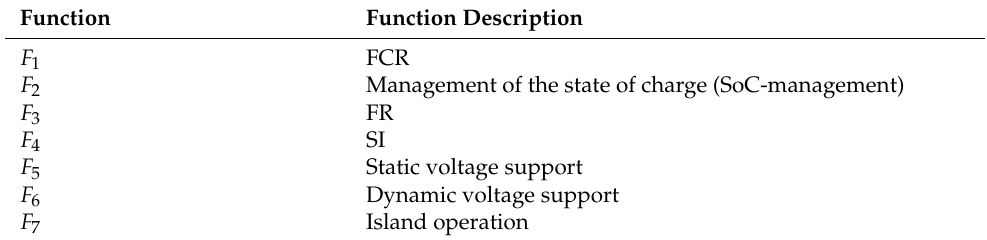
Table 1. Overview of selected functions.